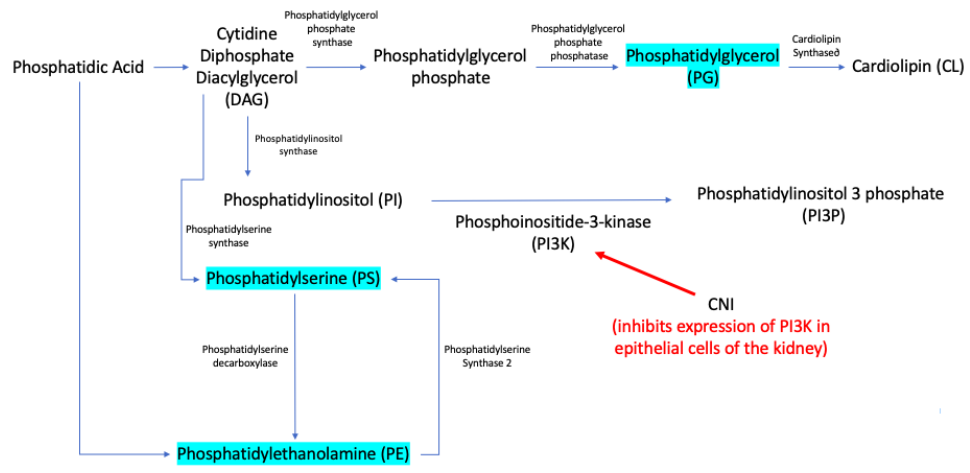
Figure 5. Lipid metabolic